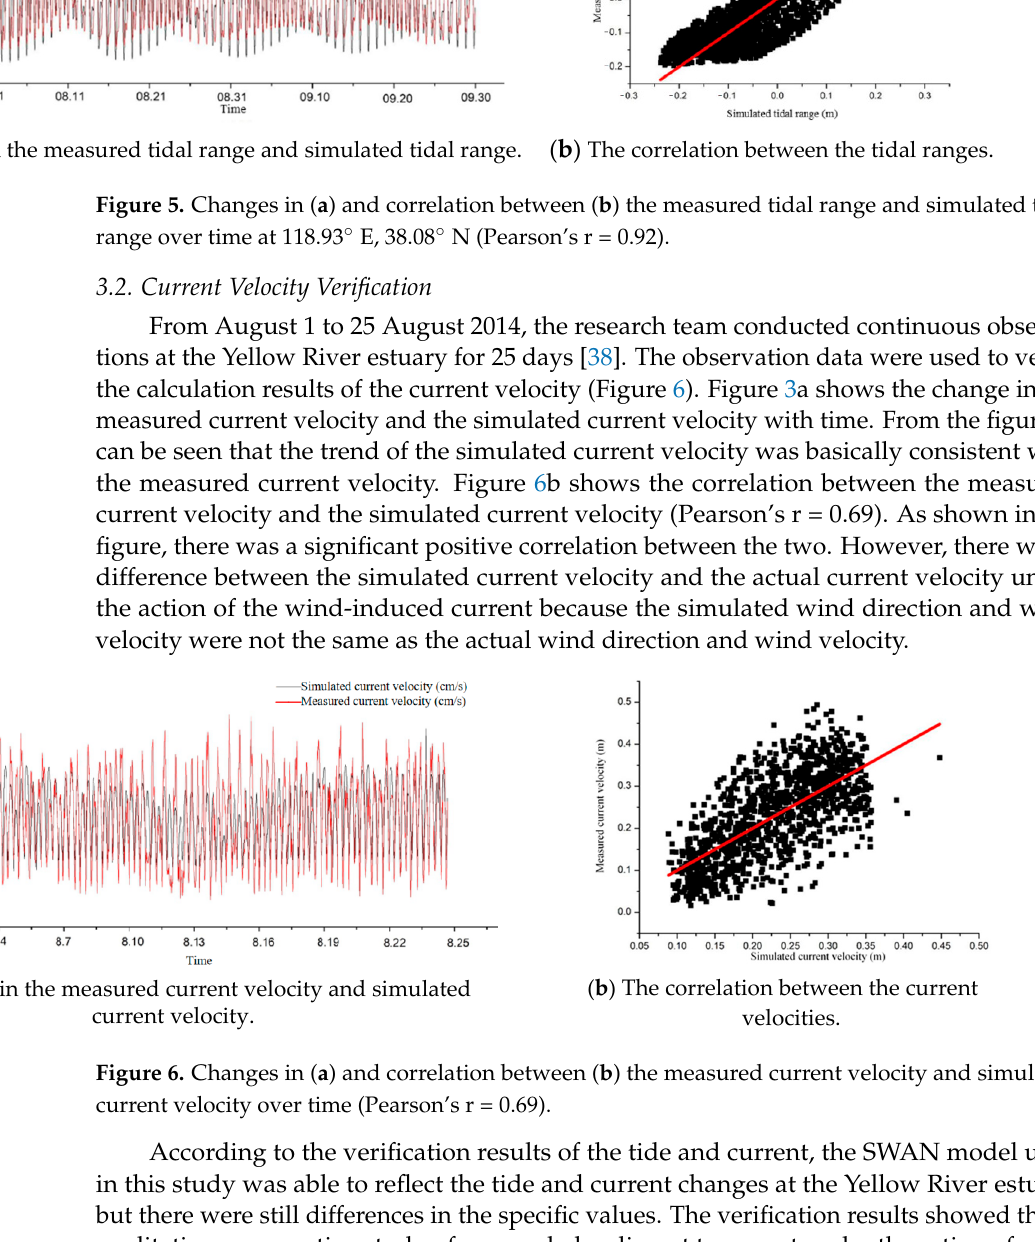
Figure 4. Changes in ( a ) and correlation between ( b ) the measured tidal range and simulated tidal range over time at 119.16° E, 37.19° N (Pearson’s r = 0.94).